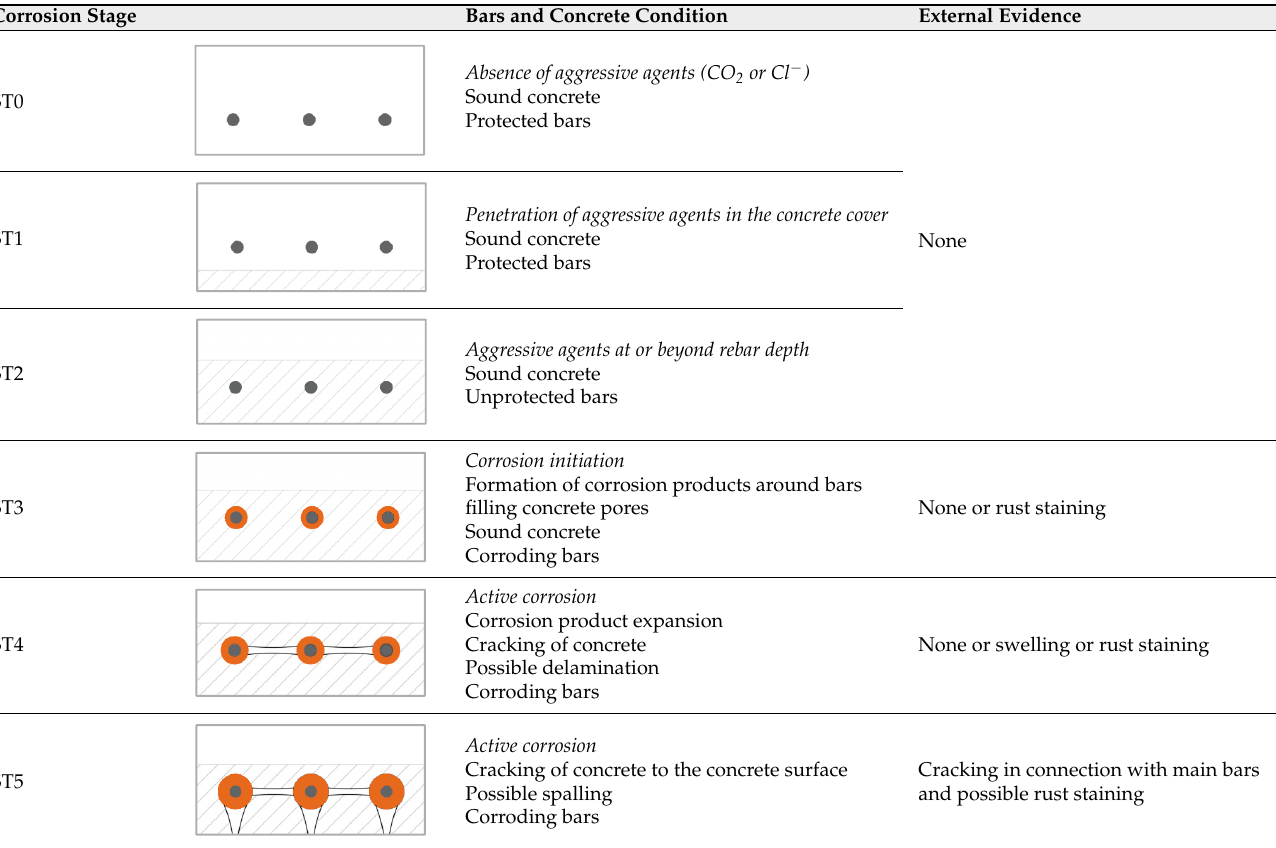
Table 1. Schematic representation of the corrosion stages of steel bars in concrete.